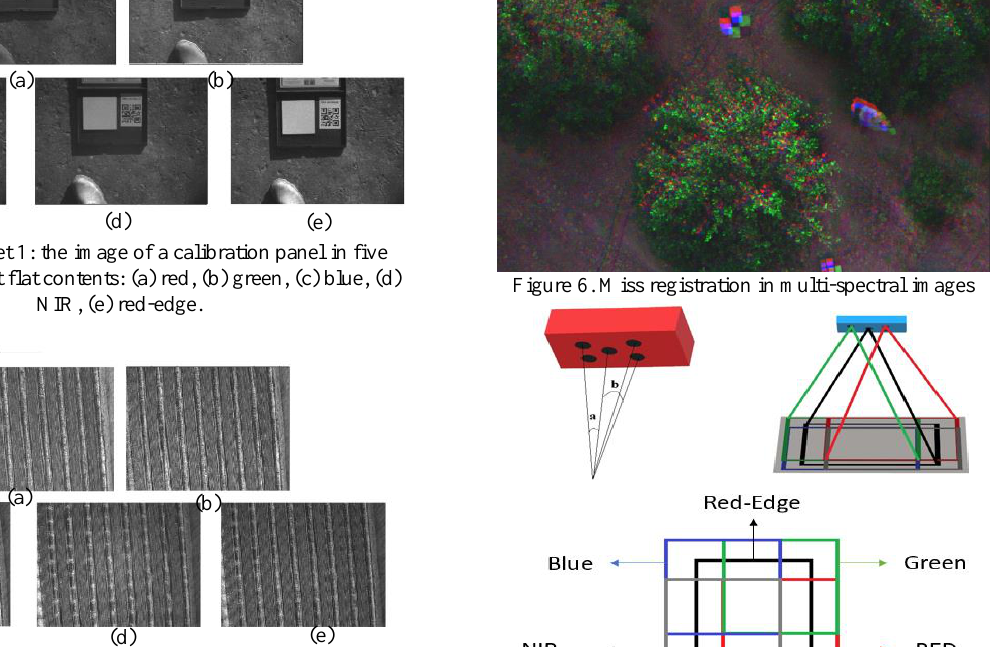
Figure 4. Data set 2: the image of an agricultural area in five bands with contents of mid height relief: (a) red, (b) green, (c) blue, (d) NIR, (e) red-edge.